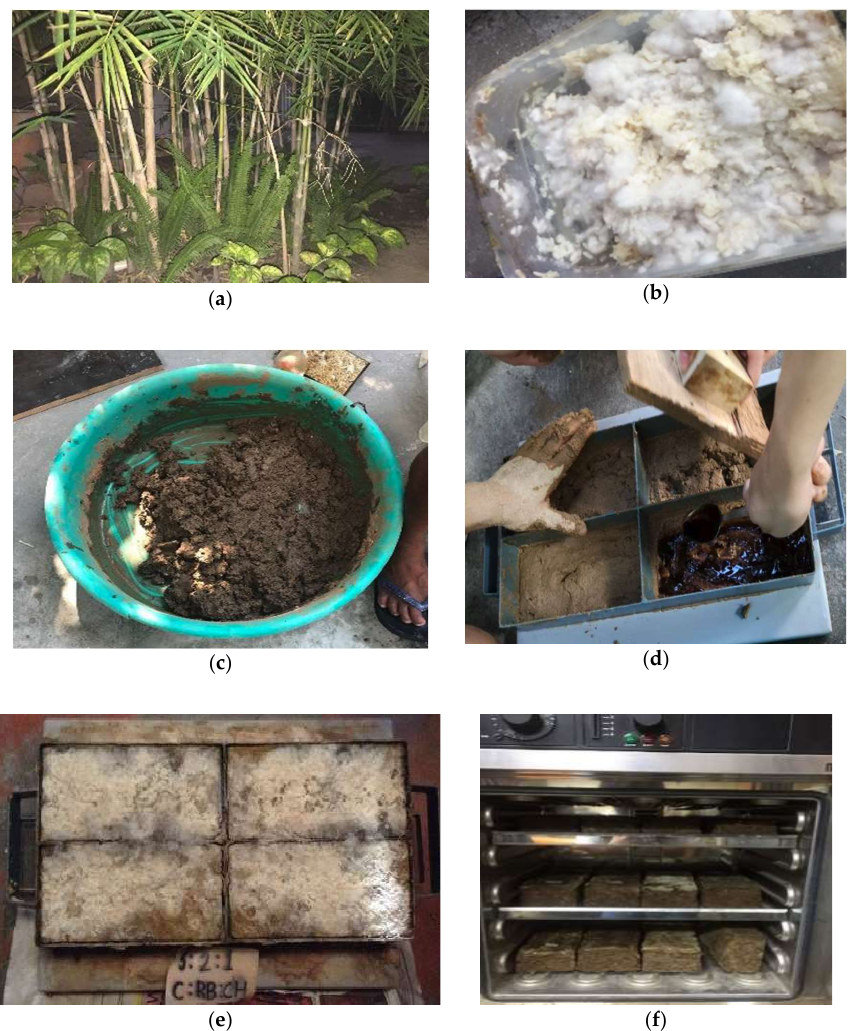
Figure 3. (a) Rice substrate buried under bamboo; (b) mycelium serum preparation; (c) weighing and mixing of main substrate mix; (d) production of bricks; (e) curing of mycelium bricks; (f) oven drying of bricks.